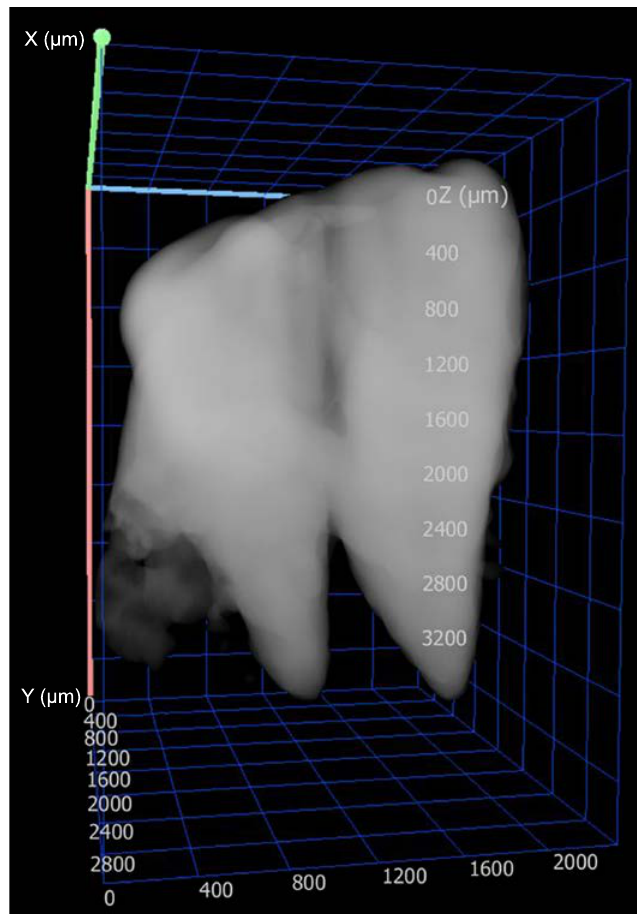
Fig. 2. CT-scan isolating two teeth of Carcharhinidae indet. that are embed- ded in the carcharhinid centrum (CMM-V-2700) from the Miocene Calvert Formation in Chesapeake Beach, MD,